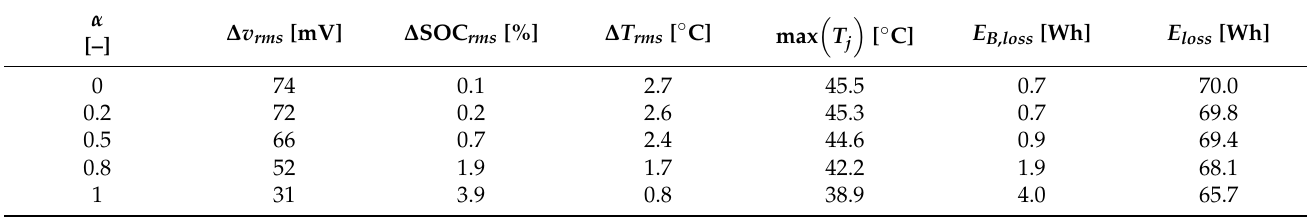
Figure 18. Sensitivity analysis: dual balancing (SOC and voltage): σ 1 = 2000 ( 1 − α ) , σ 2 = 0, σ 3 = 250 α . Scenario: fast charging, mixed aging, parallel forced air cooling ( h = 15 W/m 2 K). All cases using the CP-CV charge profile of the ‘no control’ case. Table 7. Key metrics of dual balancing (SOC and voltage) results of Figure